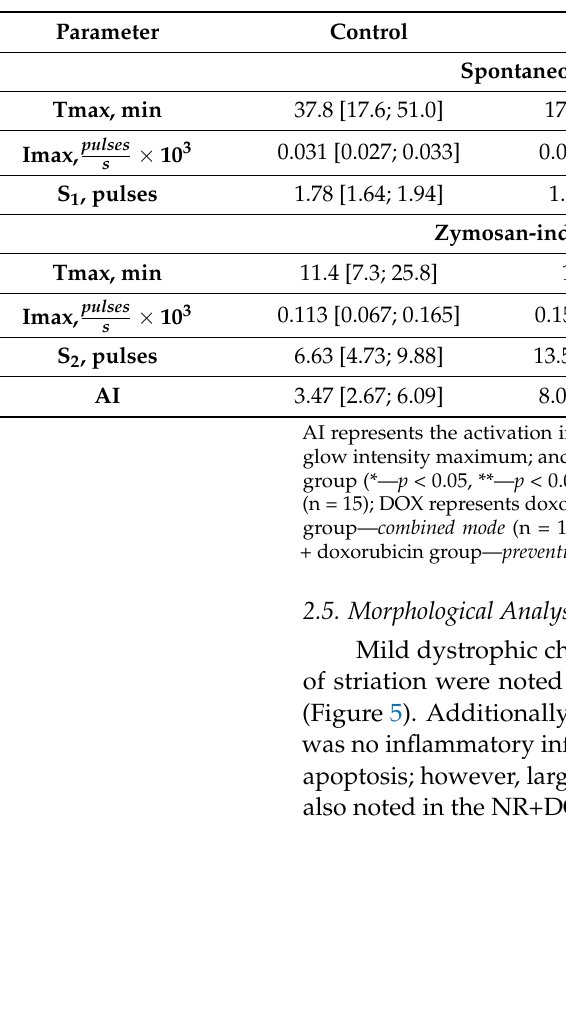
Table 2. Results of spontaneous and induced